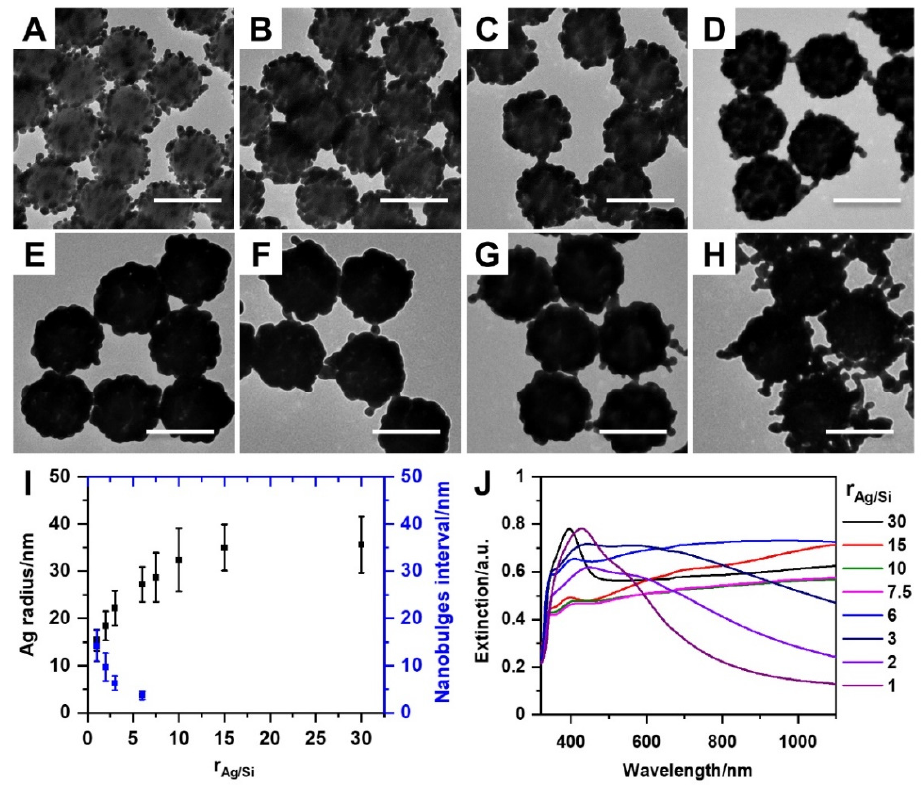
Figure 1. TEM images of SiO 2 @nAg, obtained at a weight ratio of AgNO 3 to SiO 2 (r Ag/Si ) of ( A ) 1, ( B ) 2, ( C ) 3, ( D ) 6, ( E ) 7.5, ( F ) 10, ( G ) 15 and ( H ) 30, with ( I ) an extracted size of Ag nanobulges and ( J ) corresponding extinction spectra. All scale bars in Figure ( A – H ) correspond to 200 nm.